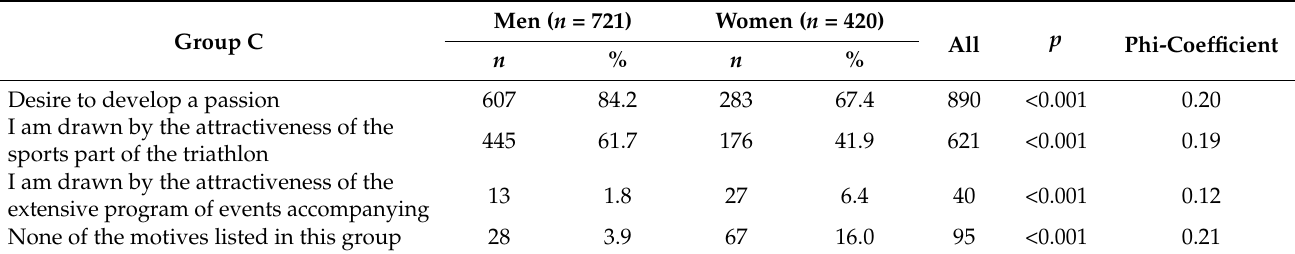
Table 4. Motives within the scope of factual